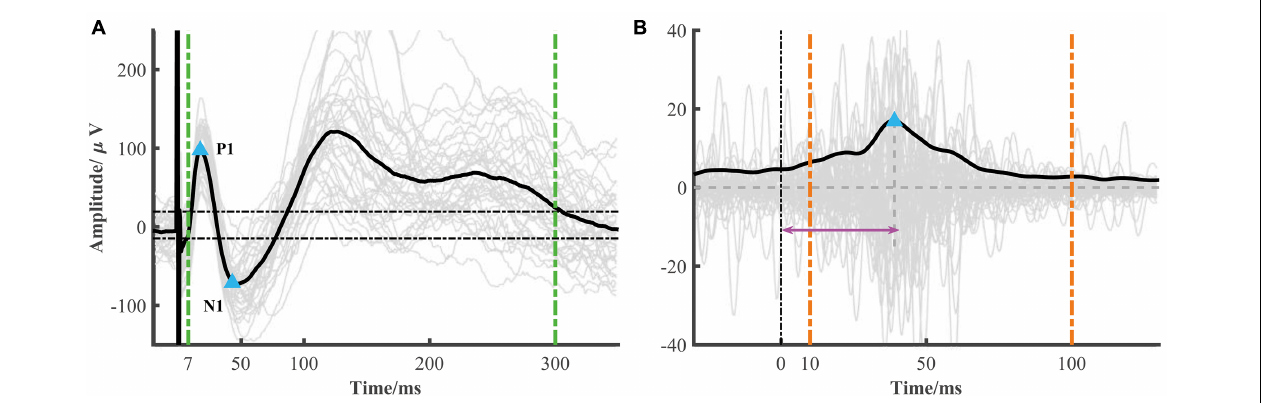
FIGURE 2 | Low- and high-frequency responses extracted from a single session. (A) A representative curve of low-frequency response (black line) averaged from each epoch response (gray lines). The blue triangles represent significant N1 and P1 peak response which is determined by 6 standard deviations of baseline (the two horizontal dotted lines) and in the time range from 7 to 50 ms. The RMS is calculated from 7 to 300 ms after stimulation (two green vertical dotted lines). (B) A representative curve of high-frequency response (black line), i.e., the averaged broadband gamma envelop signal over different epochs (gray lines). The variance is calculated from the averaged gamma envelop from 10 to 100 ms after electrical stimulation (two orange vertical dotted lines). The blue triangle represents high-frequency peak response. The peak latency is marked by the pink